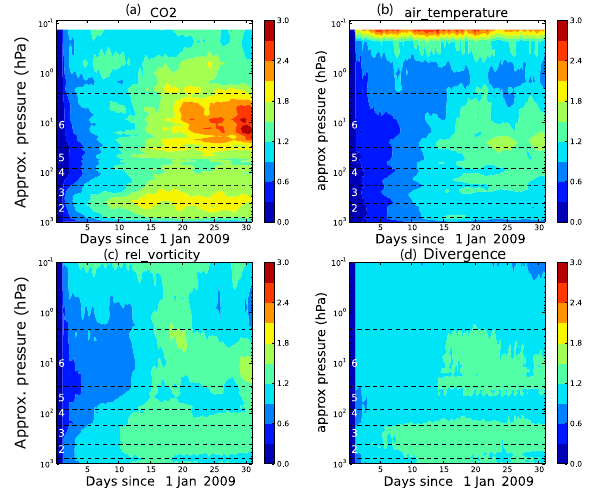
Figure 9. Predictability on weather timescales during January 2009. Predictability error is defined here as the global mean zonal stan- dard deviation of the difference in evolution of a control cycle from a climate cycle. This value is normalized by the global mean zonal standard deviation of the corresponding field in the initial condition. Predictable regimes are ones for which this ratio is much less than 1. The normalized predictability error fields for (a) CO 2 , (b) tem- perature, (c) vorticity and (d) divergence are plotted as a function of model vertical level (converted to approximate pressure with a ref- erence surface pressure of 1000hPa) and time in days since 1 Jan- uary 2009. The layers labelled with white text in each panel will be used for computing the layer mean averages shown in Fig.